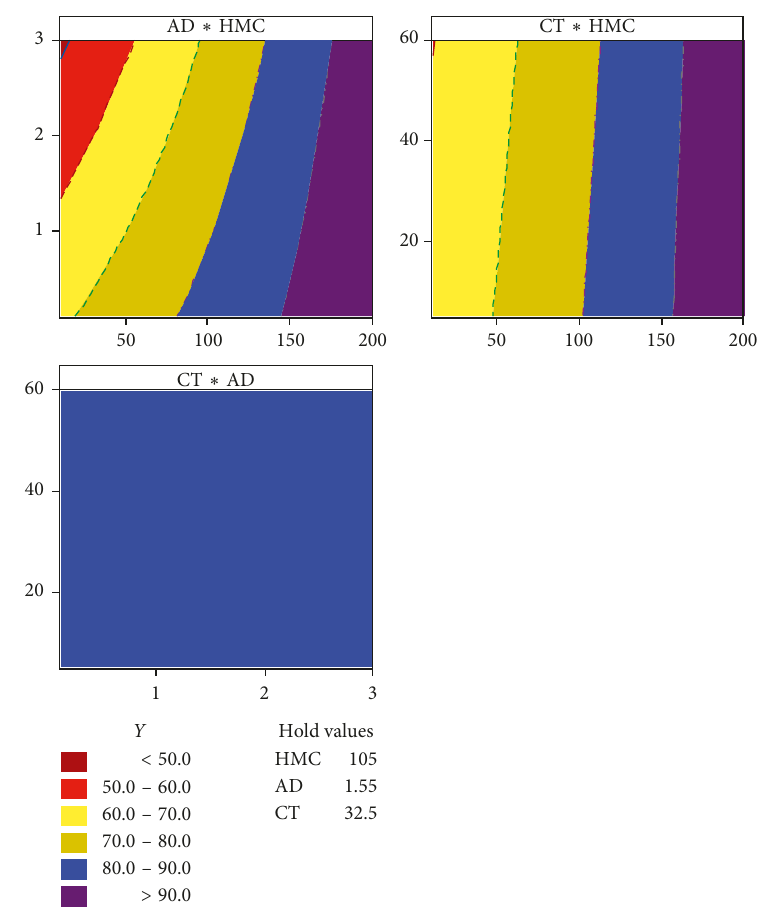
Figure 5: 2D plots (contours) of model variables.